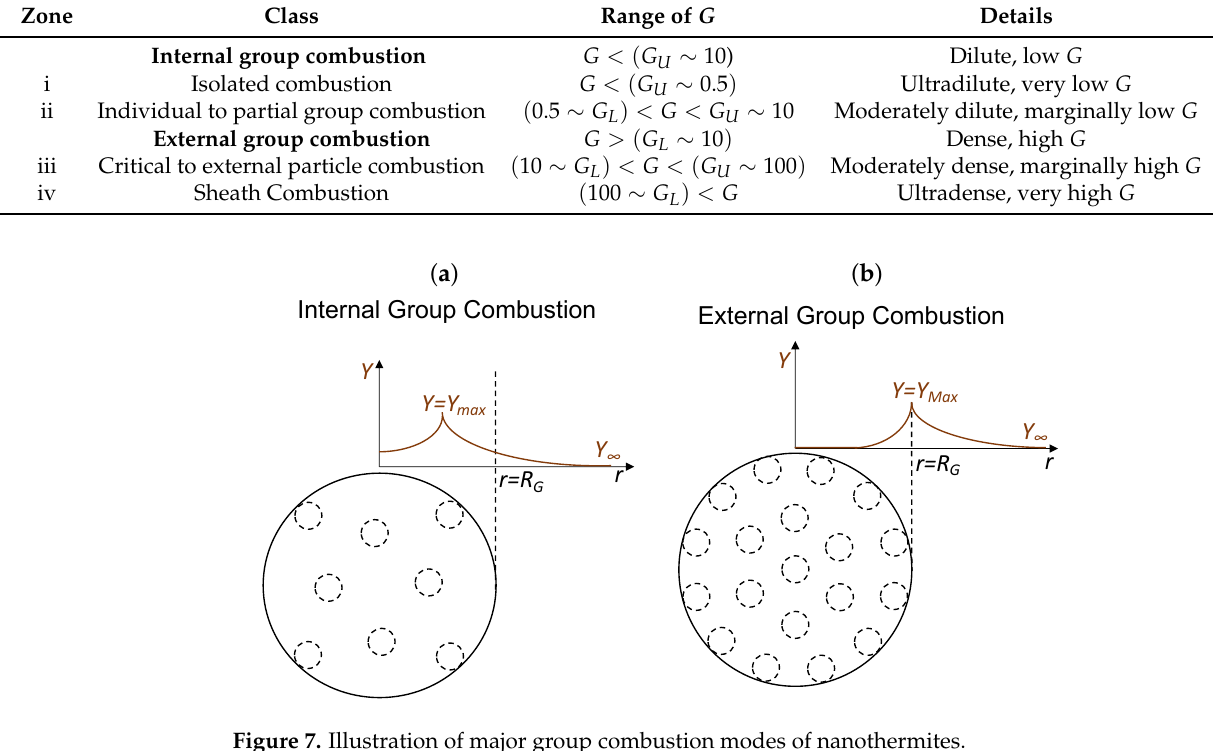
Table 2. Summary of classifications of nanothermite groups based on range of group combustion number ( G ). G L represents the lower limit and G U represents the upper limit of the group combustion regimes, respectively.